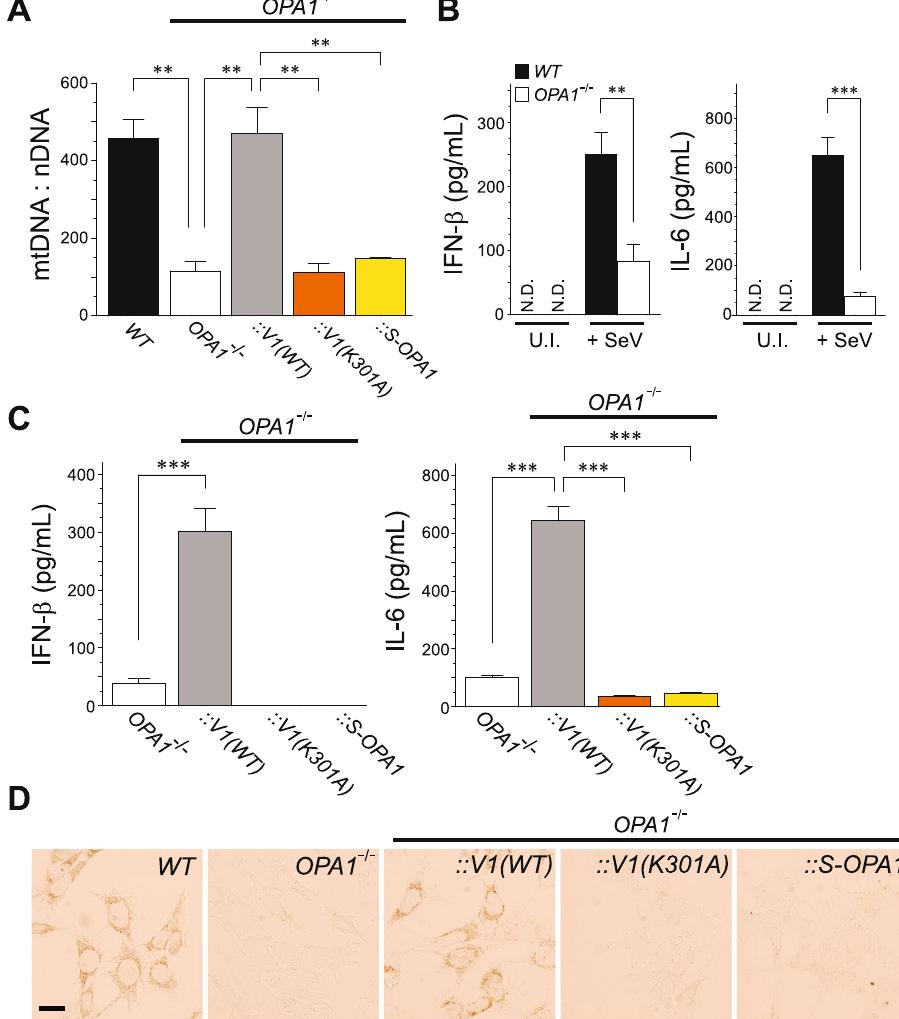
Figure 6. OPA1 contributes to mitochondrial-mediated antiviral signaling through stabilizing mtDNA. ( A ) Analysis of mtDNA copy number per nuclear DNA in WT and mutant MEFs. Restoration of mtDNA in OPA1 null cells was measured in mutant cells infected with a retrovirus-expressing variant 1 WT OPA1 [ V1(WT) ], its K301A mutant [ V1(K301A) ], and short isoform OPA1 ( S-OPA1 ). Error bars indicate SEM ( n = 3; Unpaired t -test; ** P < 0.01). ( B ) SeV-induced antiviral innate immune response in OPA1 -null MEFs. The WT and OPA1 -null MEFs were either uninfected (U.I.) or infected with SeV (4 HAU/mL) for 18 h, and the cell-free supernatants were analyzed by ELISA to measure the secreted amounts of IFN- β (left panel) and IL-6 (right panel). Error bars indicate SD ( n = 3; Unpaired t -test; ** P < 0.01 and *** P < 0.001, respectively). N.D., not detected. ( C ) Similar to ( B ), except that the immune response in mutant OPA1 MEFs was monitored. Error bars indicate SD ( n = 3; Unpaired t -test; *** P < 0.001). ( D ) Cytochemical analysis of COX activity. Cells expressing COX activity were indicated by a brown color. Scale bar, 20 μ